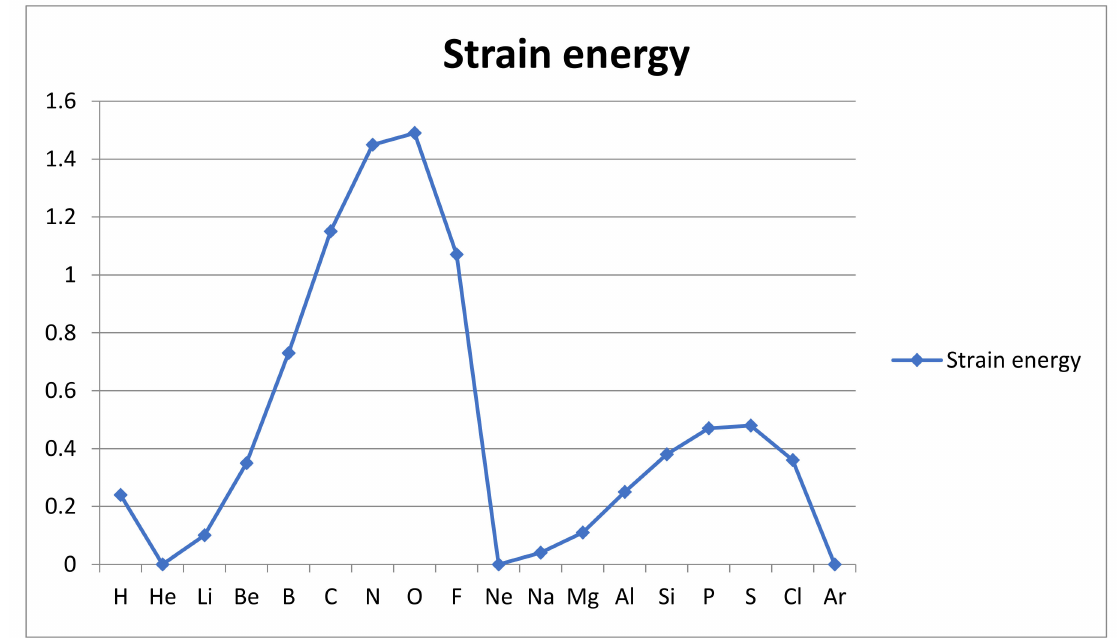
Figure 7. Atomic strain energy due to conservation laws are shown in a. u. (1 a. u. = 2626 kJ/mol). The estimates for the atoms H through Ar are obtained from a simplified and extended form of Thomas-Fermi theory. See references [32,33,50] for more